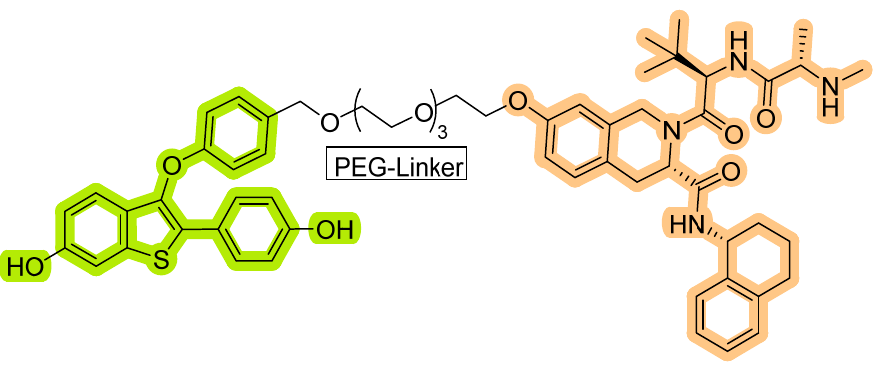
Figure 16. Patented SNIPER structure by GSK.